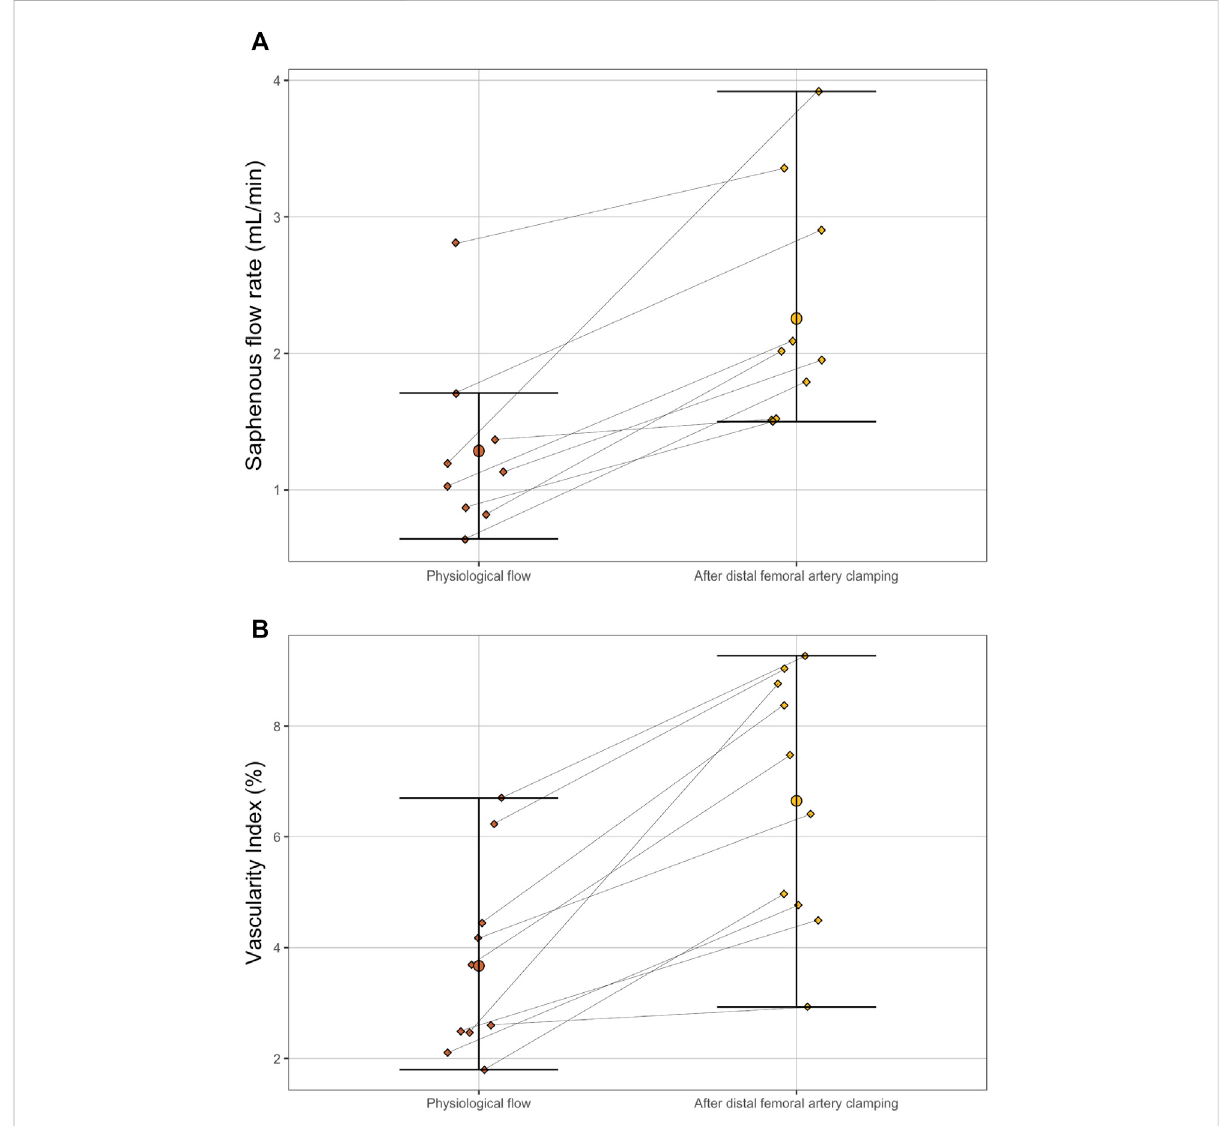
FIGURE 5 Paired dot plot of saphenous artery fl ow rate (A) and Vascularity Index (B) between physiological fl ow (before the distal femoral artery camping maneuver) and after (B) . The differences were signi fi cant for both parameters according to paired Wilcoxon test ( p = 0.004 for the fl ow rate and p = 0.002 for the Vascularity